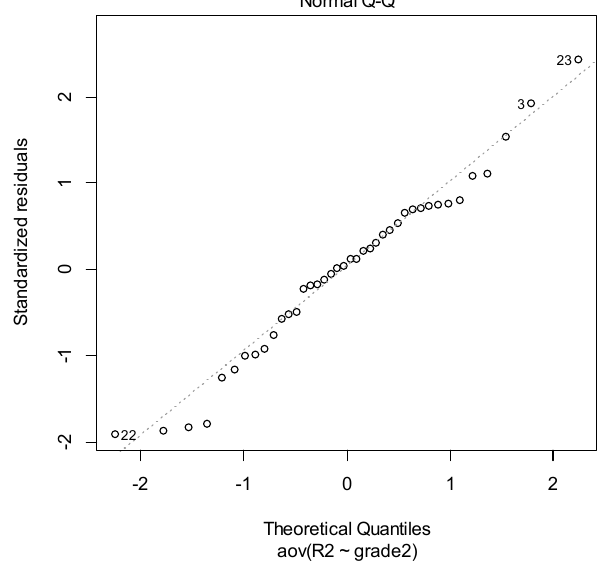
Figure 10. Q – Q plot from ANOVA in DETAX case.